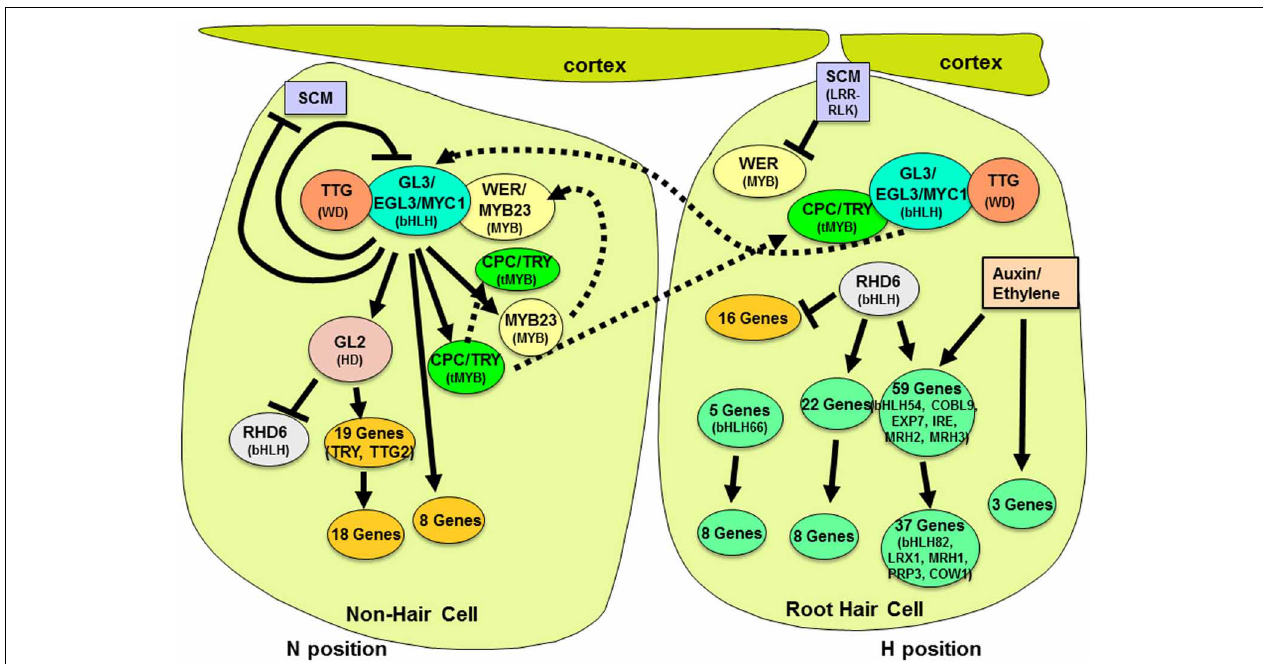
FIGURE 1 | Molecular genetic regulation of cell fate specification in the Arabidopsis root epidermis. Root-hair specific gene expression occurs in differentiating epidermal cells located in a cleft between adjacent cortical cells (right-most cell). Gene regulatory activity is indicated by solid lines with arrows (positive transcriptional effect) or bars (negative transcriptional effect).